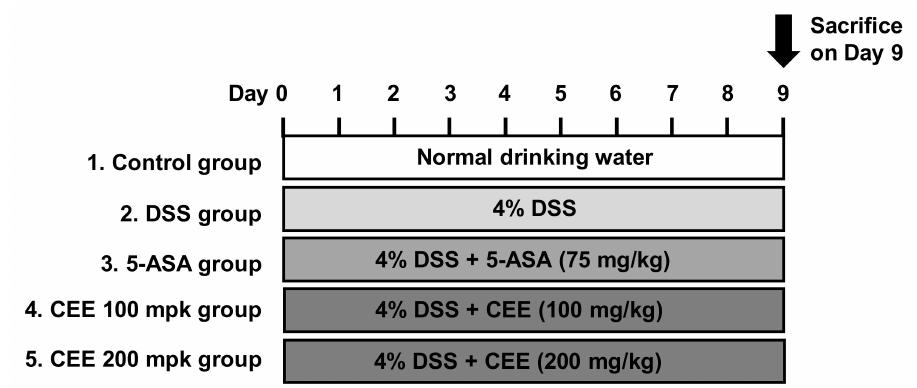
Figure 1. Design of animal